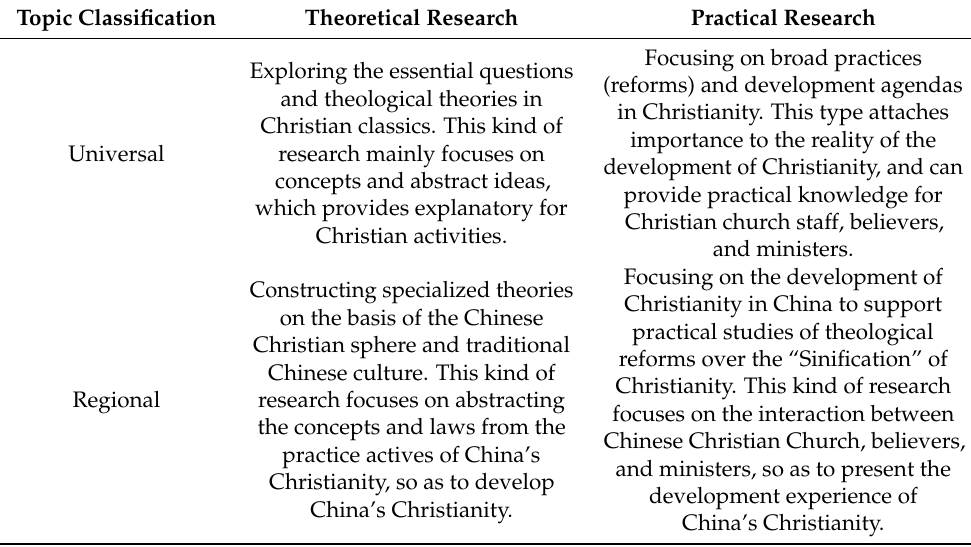
Table 1. A classification framework for Christian research. Topic